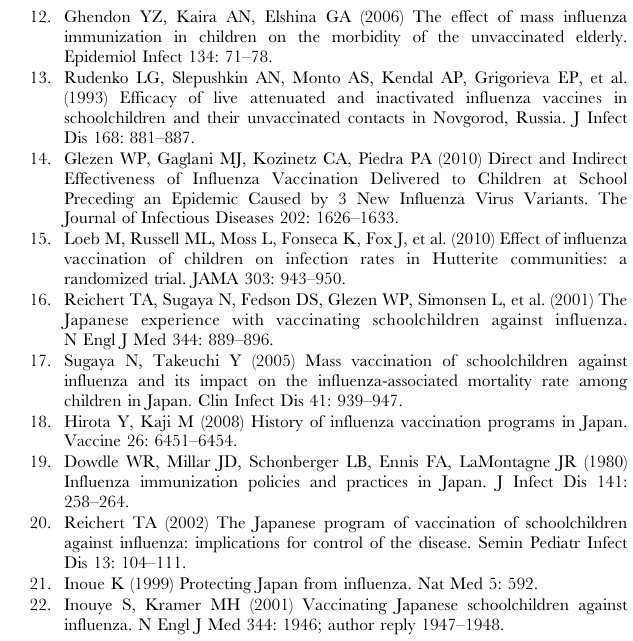
Table S2 Underlying cause of death codes used to identify mortality due to pneumonia and influenza (P&I: Pneumonia and Influenza, ICD: International Classification of diseases). Table S3 Crude and adjusted influenza-related excess mortality rates per 100,000 among Japanese and Amer- ican seniors aged 65–89 yrs, and dominant influenza subtypes in circulation, 1978–2006. Adjusted mortality rates, standardized to the US population structure of 2000 and adjusted for time trends in the baseline risk of mortality, are displayed in parentheses. Table S4 Comparison of crude and adjusted excess P&I mortality rates per 100,000 among Japanese and US seniors in 1978–1994 with those in 1995–2006. Adjusted rates take into account time trends in baseline mortality risk. Percent changes were calculated as the mean mortality rate in 1995–2006 minus that in 1978–1994, divided by the mean mortality rate in 1978–1994. P-values were determined using Wilcoxon’s Rank Sum Test. Table S5 Comparison of adjusted excess P&I mortality rates per 100,000 between Japanese and American seniors, aged 65–89. Standard deviations are tabulated in parentheses. P-values were determined using Wilcoxon’s Rank Sum Test. Table S6 Sensitivity analysis including US and Japan mortality data in the same model. We modeled age- adjusted excess P&I estimates in Japan and the USA using multivariate negative binomial regression. Adjusted excess P&I estimates were standardized to the US summer mortality rate of 2000. We evaluated three different vaccination periods (Japan 1978–1994, schoolchildren vaccination; Japan 1995–2006, mixed vaccination; USA 1978–2006, elderly vaccination), adjusting for